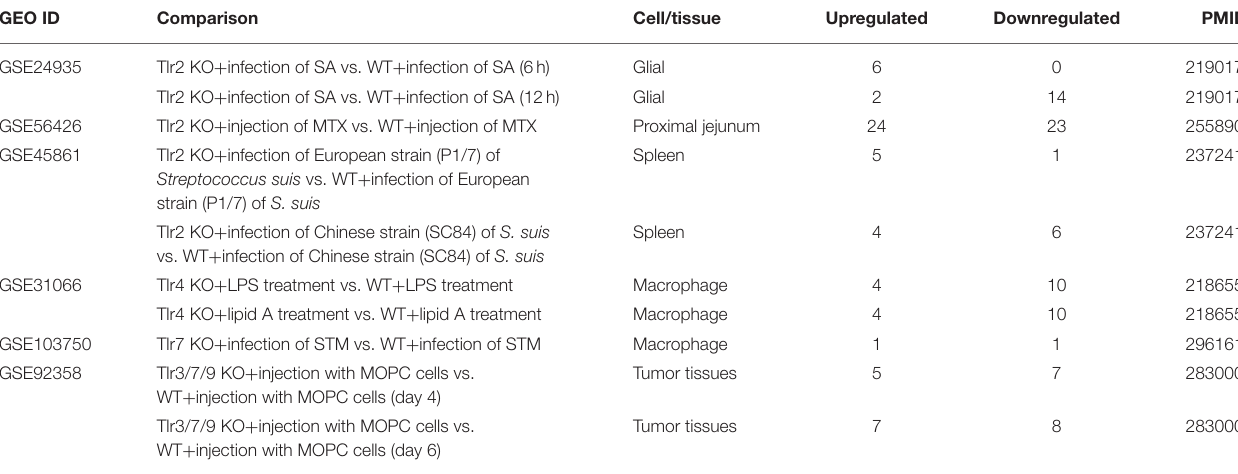
TABLE 7 | Six microarrays of toll-like receptor deficiencies in the National Institutes of Health (NIH)–National Center for Biotechnology Information (NCBI)–Gene Expression Omnibus (GEO) datasets database (https://www.ncbi.nlm.nih.gov/gds/) were collected to analyze the expression changes of organelle crosstalk regulators (OCRGs) ( p < 0.05, |logFC| > 1).